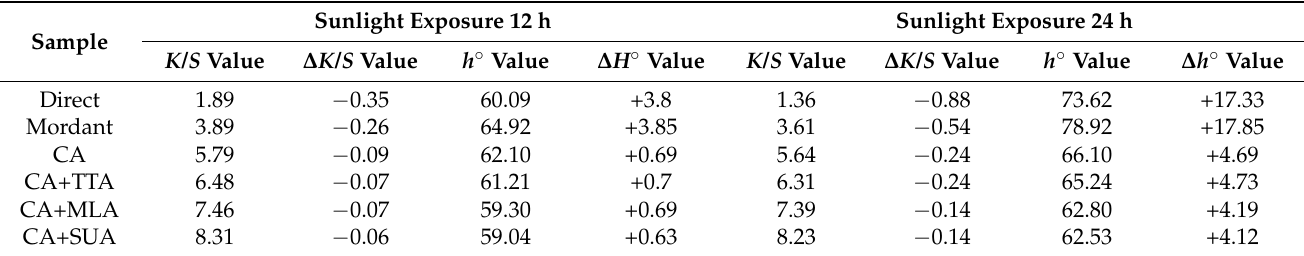
Table 5. The K/S and h ◦ values of the dyed cotton fabrics at sunlight exposure 12 h and 24 h.